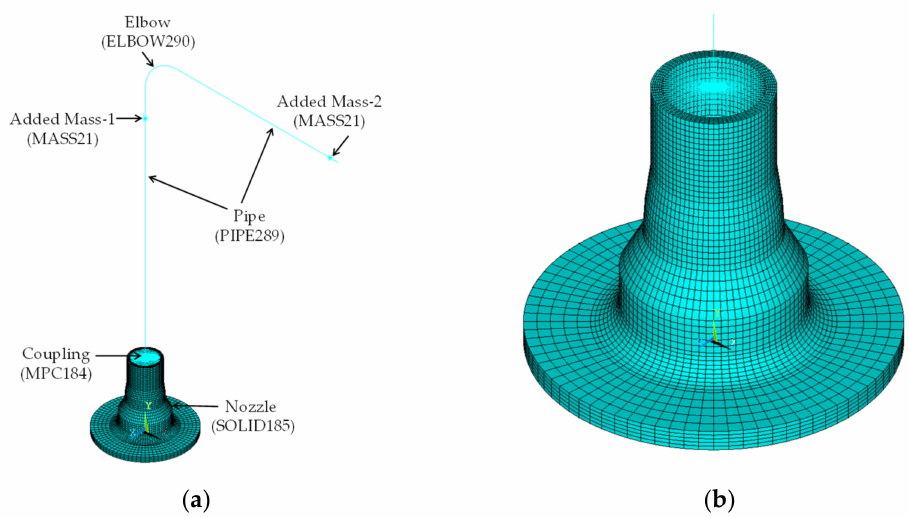
Figure 3. Finite element analysis model: ( a ) total model; ( b ) zoomed nozzle model.